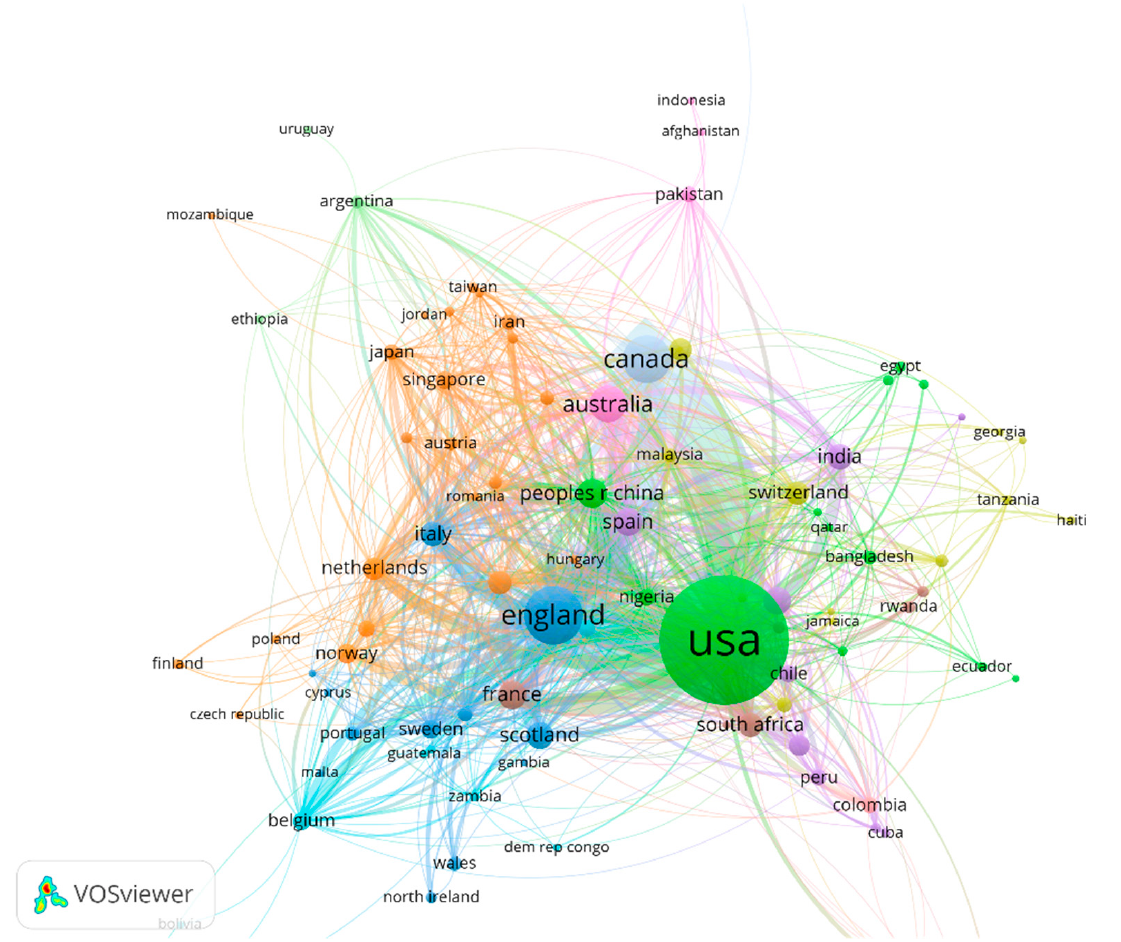
Figure 2. The co-operation networks of countries or regions. Note(s): Colors represent clusters, the thickness of linked lines represents intensity of co-operation, and node sizes represent the number of publications. Table 3. The countries cooperation network ranked by total link